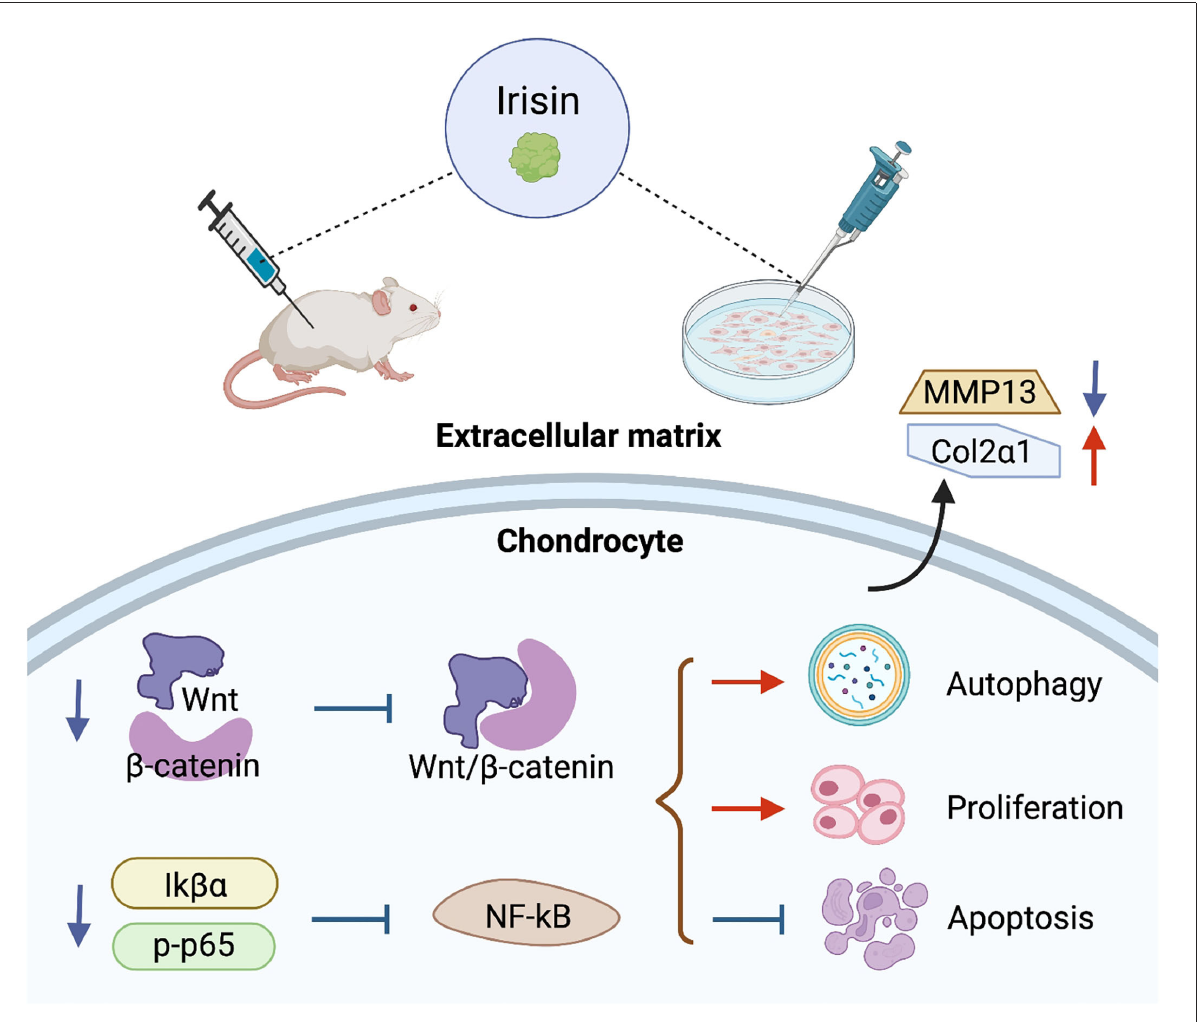
FIGURE5 Regulatory role of irisin in chondrocyte metabolism. Irisin inhibits the activation of Wnt/ β -catenin and NF- κ B signaling pathways in osteoarthritic chondrocytes, promotes cell autophagy and proliferation, inhibits apoptosis, and improves the stability of the extracellular